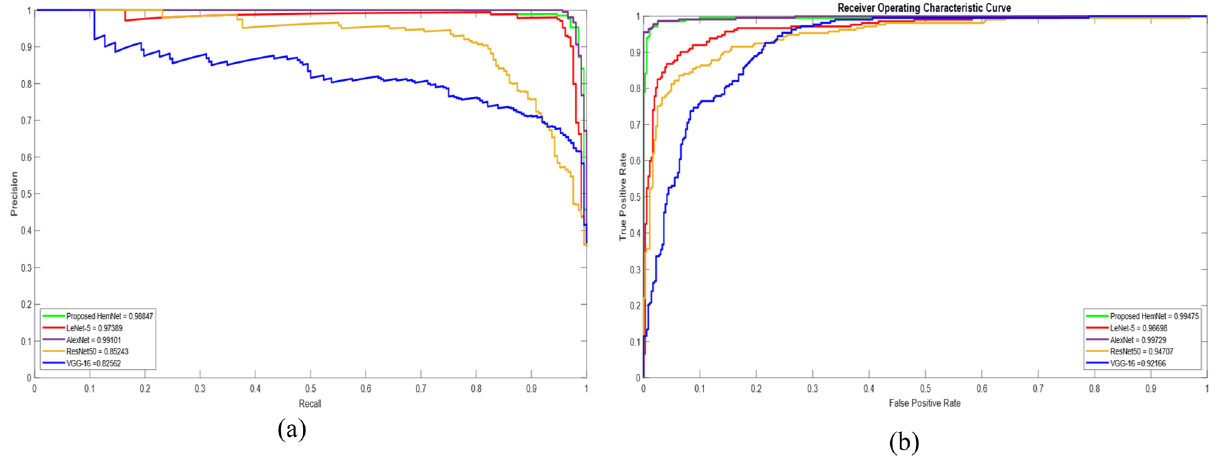
Figure 6. Comparison of Deep Models on the DIARETDB1 Dataset ( a ) PR curves ( b ) ROC